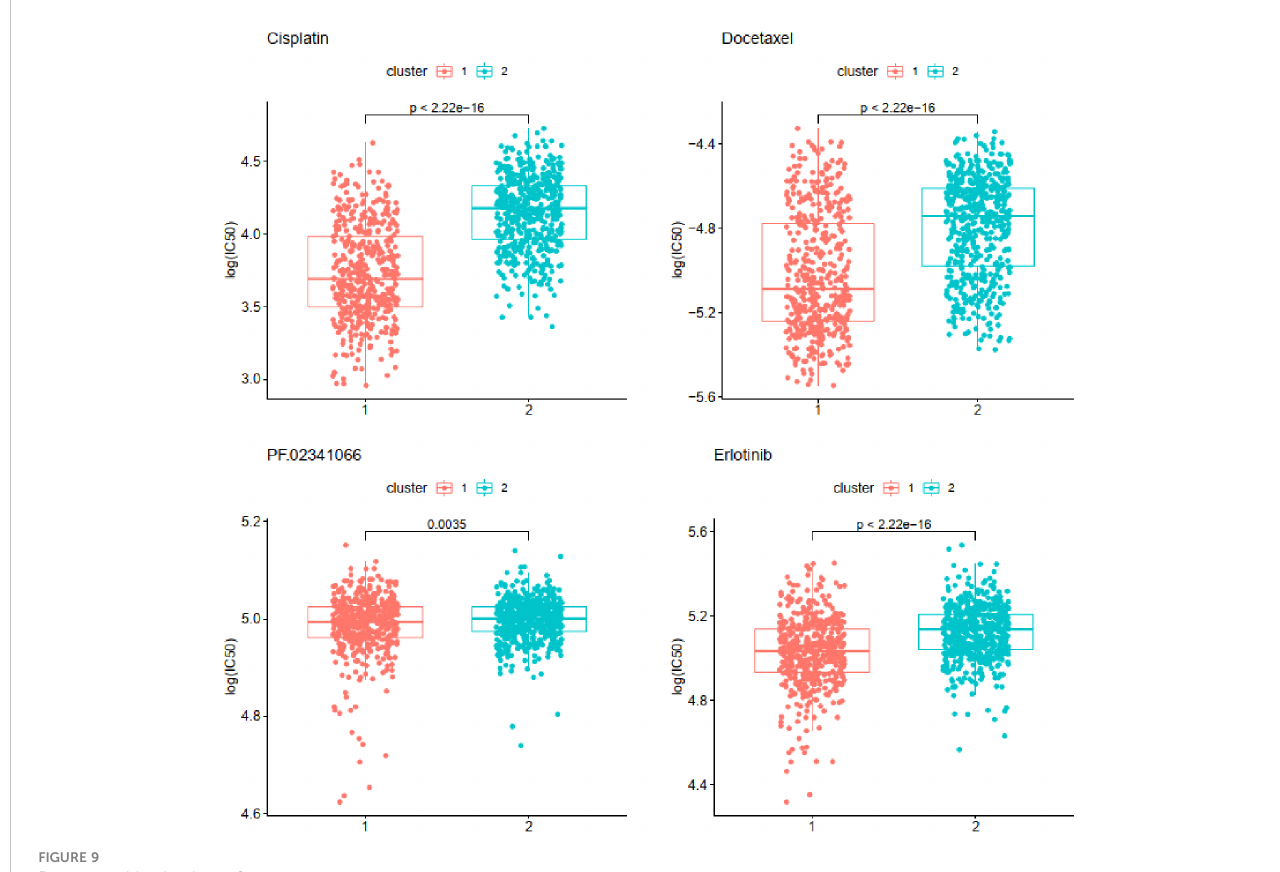
FIGURE 9 Drugs sensitive in